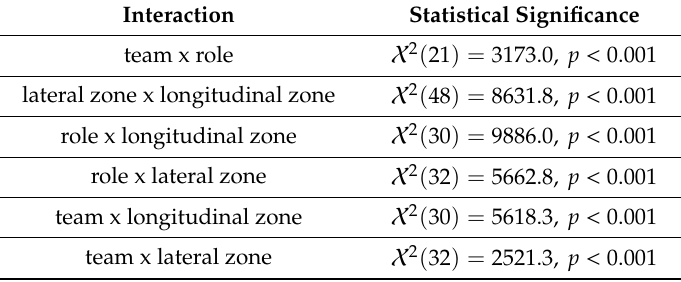
Table 1. Statistical significance of interaction with pitch zone e ff